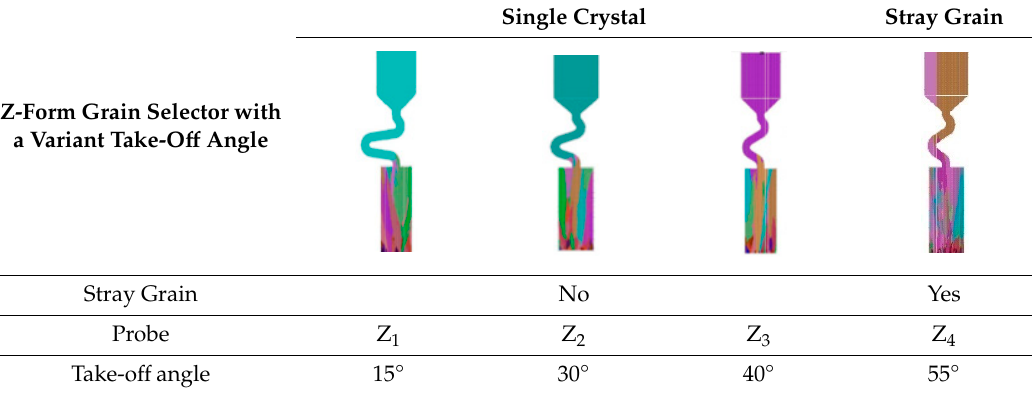
Table 4. Variant take-o ff angle parameters of Z-form selectors. Table 4. Variant take-off angle parameters of Z-form selectors. Table 4. Variant take-off angle parameters of Z-form Table 4. Variant take-off angle parameters of Z-form selectors. Table 4. Variant take-off angle parameters of Z-form selectors. Table 4. Variant take-off angle parameters of Z-form selectors. Table 4. Variant take-off angle parameters of Z-form selectors. Table 4. Variant take-off angle parameters of Z-form selectors. Table 4. Variant take-off angle parameters of Z-form selectors. Table 4. Variant take-off angle parameters of Z-form selectors.